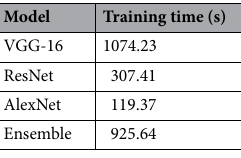
Table 6. Training time of the single and ensemble models.